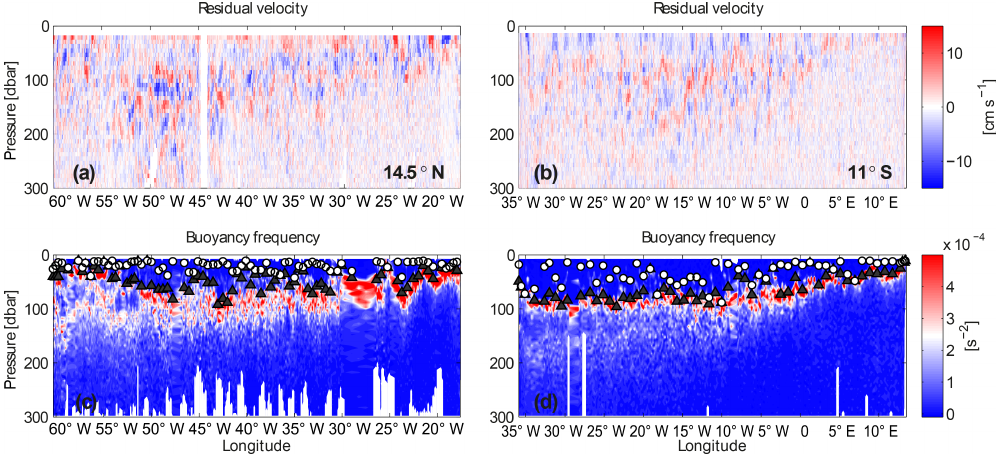
Figure 4. Vertical sections of residual meridional velocity in cms − 1 at (a) 14.5 ◦ N and (b) 11 ◦ S and of buoyancy frequency calculated from uCTD/CTD at (c) 14.5 ◦ N and (d) 11 ◦ S. Northward velocity in (a, b) is shaded in red, southward in blue. The residual velocity is calculated by subtracting an 80m boxcar filtered profile from the original ADCP profile. The white circles in (c, d) denote the MLD; the black triangles denote the TTP (see text for details). The MLD and TTP plotted here are subsampled for visual clarity. Note that no uCTD measurements were conducted between 30 and 25 ◦ W at 14.5 ◦